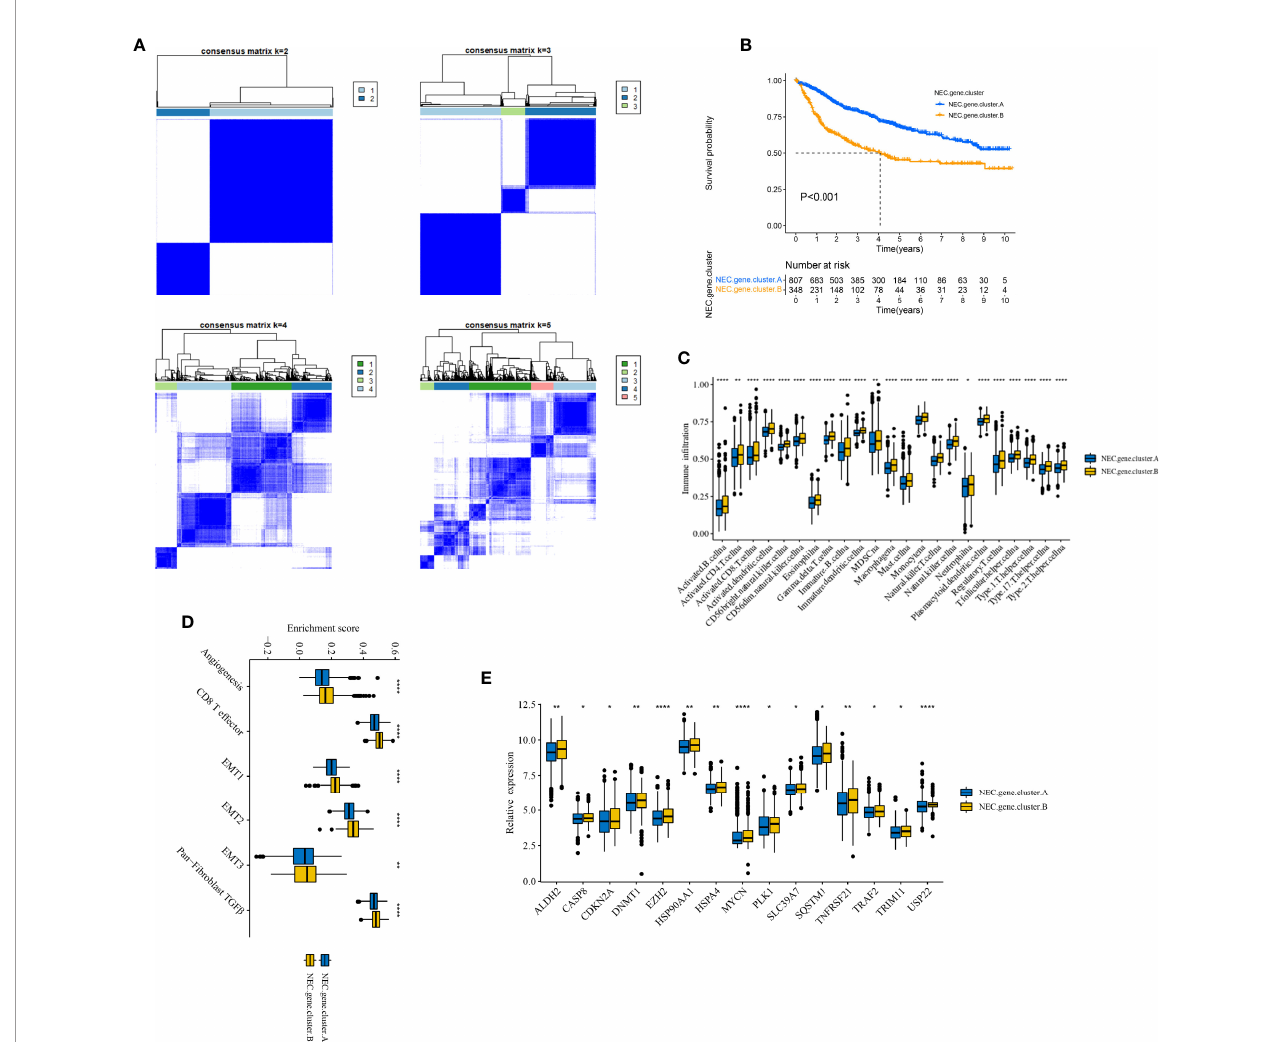
FIGURE 4 | Identi fi cation of DEGs and prognostic genes between the NEC patterns. (A) Unsupervised consensus clustering based on prognostic NEC-related differentially expressed genes to classify patients into two groups termed NEC.gene.cluster.A, NEC.gene.cluster.B. (B) Survival analyses for the two NEC.gene.clusters based on 1155 patients with HCC from fi ve cohorts (TCGA-LIHC, LIRI-JP, GSE14520, GSE36376, and GSE76427) including 807 cases in NEC.gene.cluster.A (blue), and 348 cases in NEC.gene.cluster.B (yellow). Kaplan-Meier curves with Log-rank p value < 0.001 showed a signi fi cant survival difference among two NEC.gene.clusters. The NEC.gene.cluster.A showed signi fi cantly better overall survival than the NEC.cluster.B. (C) The illustration shown the abundance of 23 immune in fi ltrating cell in NEC.gene.cluster.A (blue) and NEC.gene.cluster.B (yellow). The upper and lower ends of the boxes represented the interquartile range of values. The lines in the boxes represented median value, and black dots showed outliers (Student ’ s t test). The asterisks represented the statistical p-value (*P < 0.05; **P < 0.01; ***P < 0.001; ****P < 0.0001). (D) The illustration shown the different between stroma-activated pathways including EMT, TGF beta, and angiogenesis pathways in NEC.gene.cluster.A (blue) and NEC.gene.cluster.B (yellow). The upper and lower ends of the boxes represented the interquartile range of values. The lines in the boxes represented median value, and black dots showed outliers (Student ’ s t test). The asterisks represented the statistical pvalue (*P < 0.05; **P < 0.01; ***P < 0.001; ****P < 0.0001). (E) The illustration shown the expression of 15 necroptosis related genes between NEC.gene.cluster.A (blue) and NEC.gene.cluster.B (yellow) (Student ’ s t test). The upper and lower ends of the boxes represented interquartile range of values. The lines in the boxes represented median value, and black dots showed outliers. The asterisks represented the statistical p-value (*P < 0.05; **P < 0.01; ***P < 0.001; ****P <